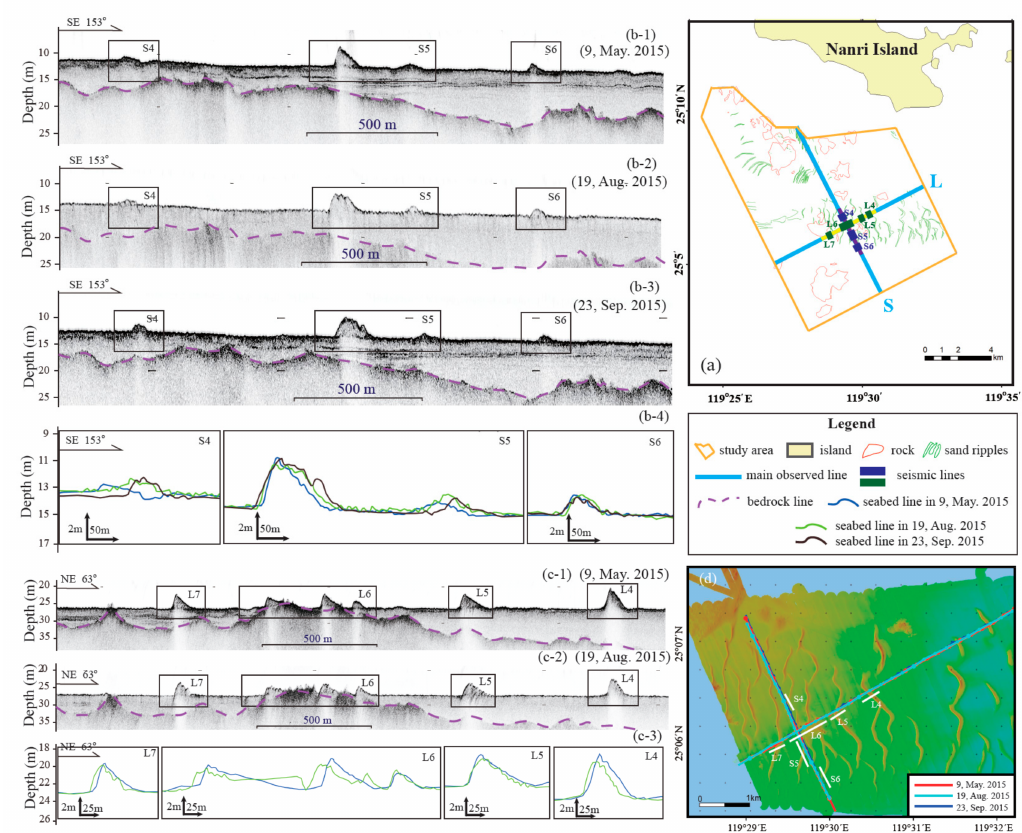
Figure 2. ( a ) Seismic profile locations and seismic profiles of S4, S5, and S6, observed on ( b-1 ) 9 May 2015; ( b-2 ) 19 August 2015; ( b-3 ) 23 September 2015; and ( b-4 ) the interpretation profiles for the three surveys; the seismic profiles of L7, L6, L5, and L4, observed on ( c-1 ) 9 May 2015; ( c-2 ) 19 August 2015, and ( c-3 ) the interpretation profiles for the two surveys and ( d ) the GPS track lines collected during three